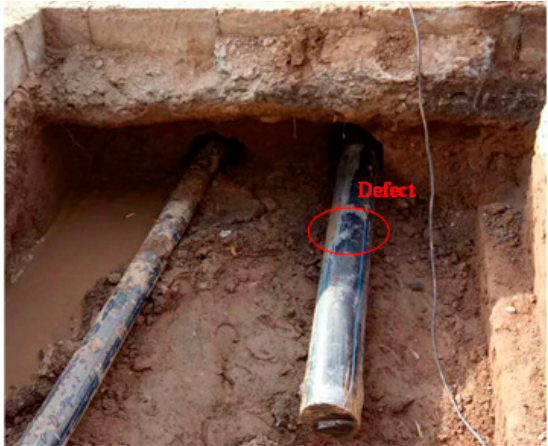
Figure 2. Image of pipe defect during trenchless construction of polyethylene pipeline.